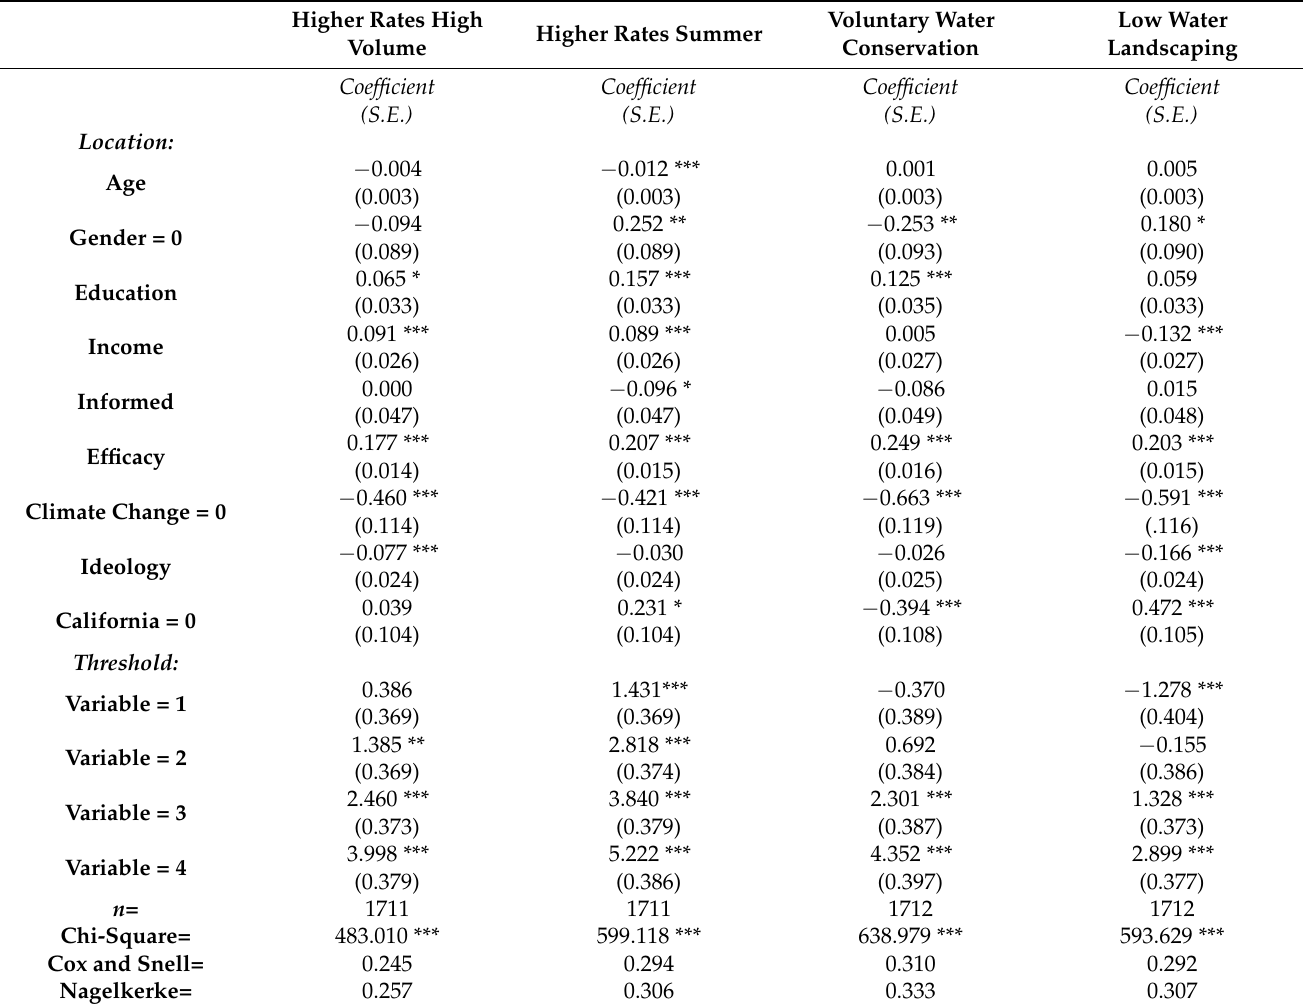
Table 5. Ordinal Regression Estimates for Water Rates and Regulatory Policy